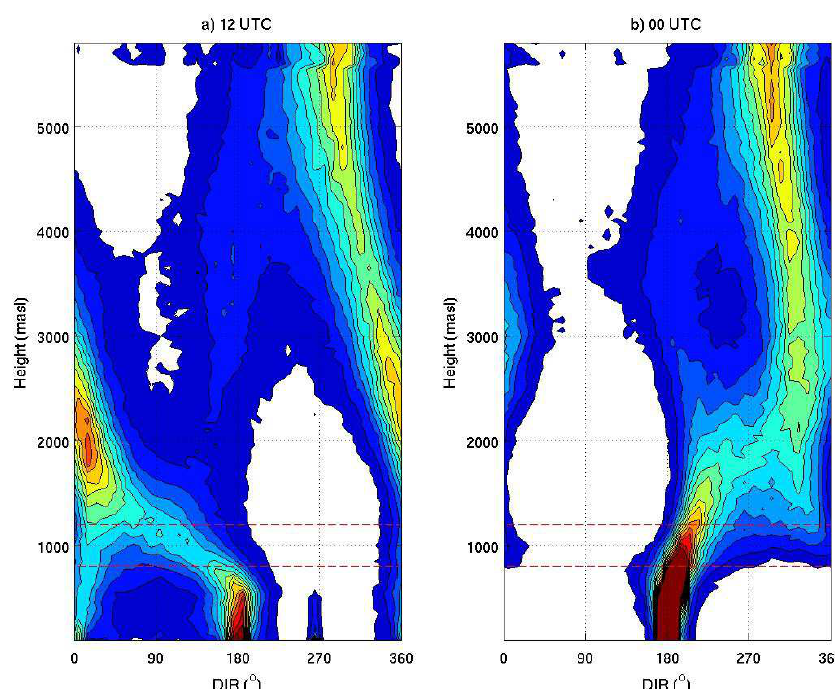
Fig. 3. Mean frequency distribution of wind directions at Antofagasta (Cerro Moreno Airport) at (a) 12:00UTC (08:00LT) and (b) 00:00UTC (20:00LT) as a function of standard height. A total of 5707 days in the 1961–1987 period was considered in the analysis for which 2 daily upper-air observations were available. Contours are shown from 1% to 15% every 1%. Horizontal dashed lines mark the height region where the subsidence inversion base is generally located at this site according to Mu˜noz et al. (2011).